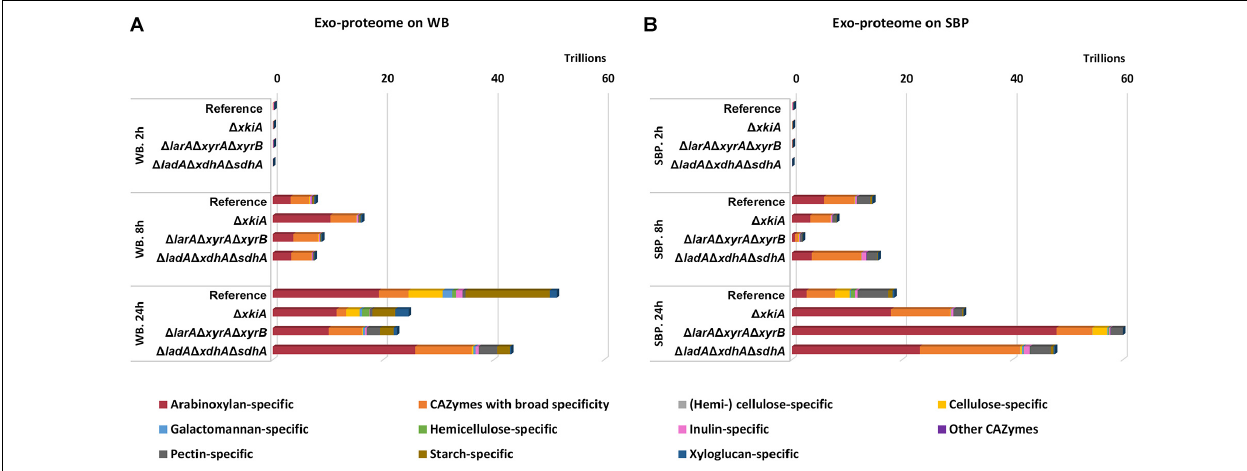
FIGURE 6 | CAZy protein abundance (protein intensity values) in the secretome of the A. niger reference strain (N593 (cid:49) kusA ) and the PCP deletion mutants grown on (A) wheat bran (WB) and (B) sugar beet pulp (SBP) for 2, 8, and 24 h.